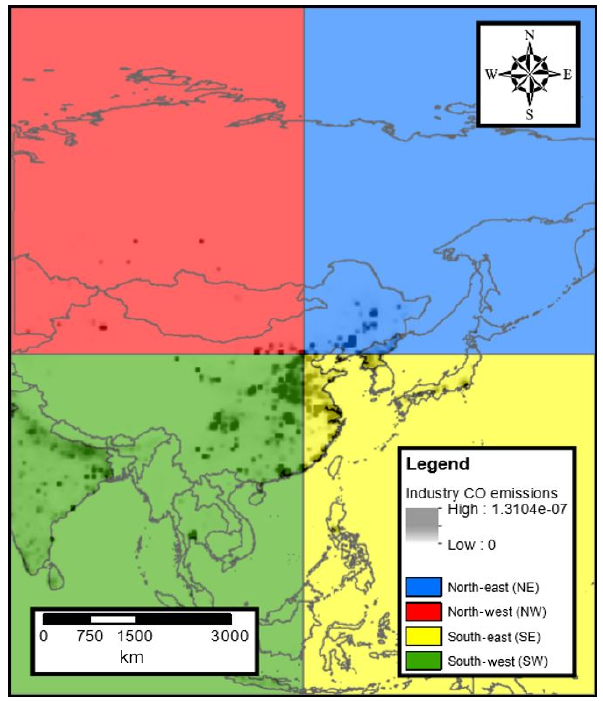
Figure 2. The four quadrants created to investigate the air masses arriving in Beijing. Industry CO emissions (kgm 2 s − 1 ) from MEIC